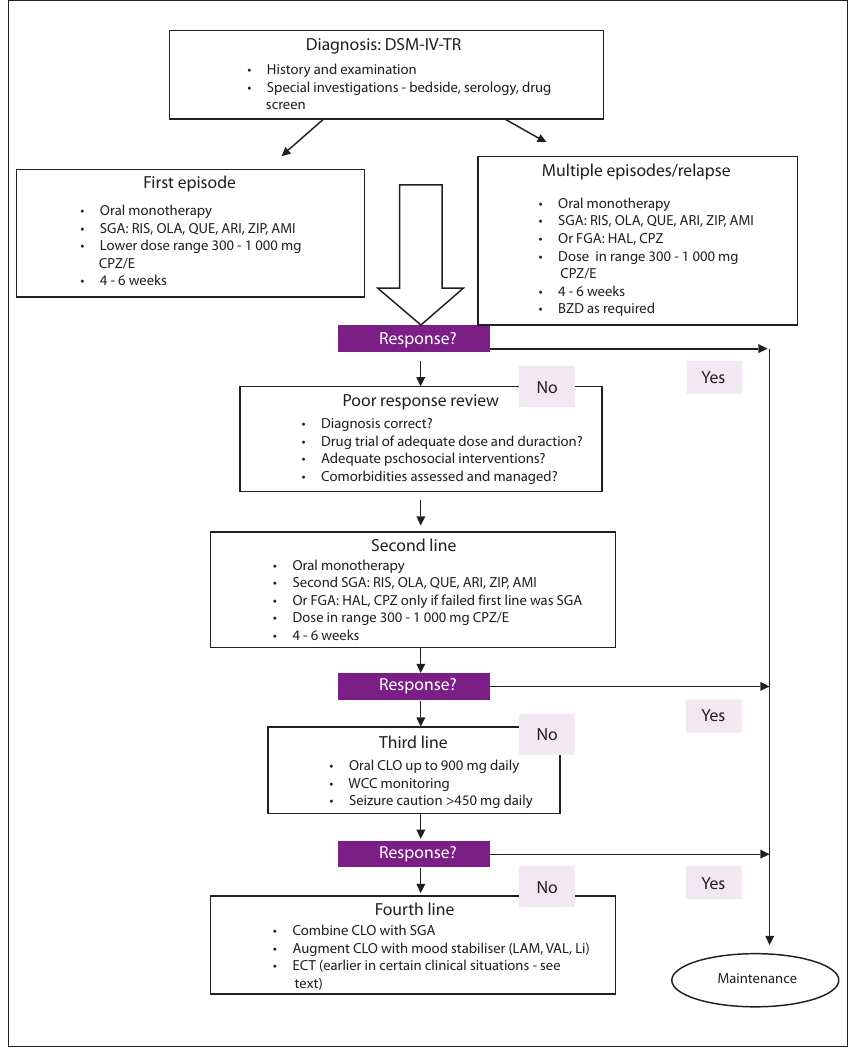
Fig. 1. Treatment algorithm. FGA = first-generation antipsychotic; HPL = haloperidol; CPZ = chlorpromazine; CPZ/E = chlorpromazine equivalents; SGA = second-generation antipsychotics; RIS = risperidone;